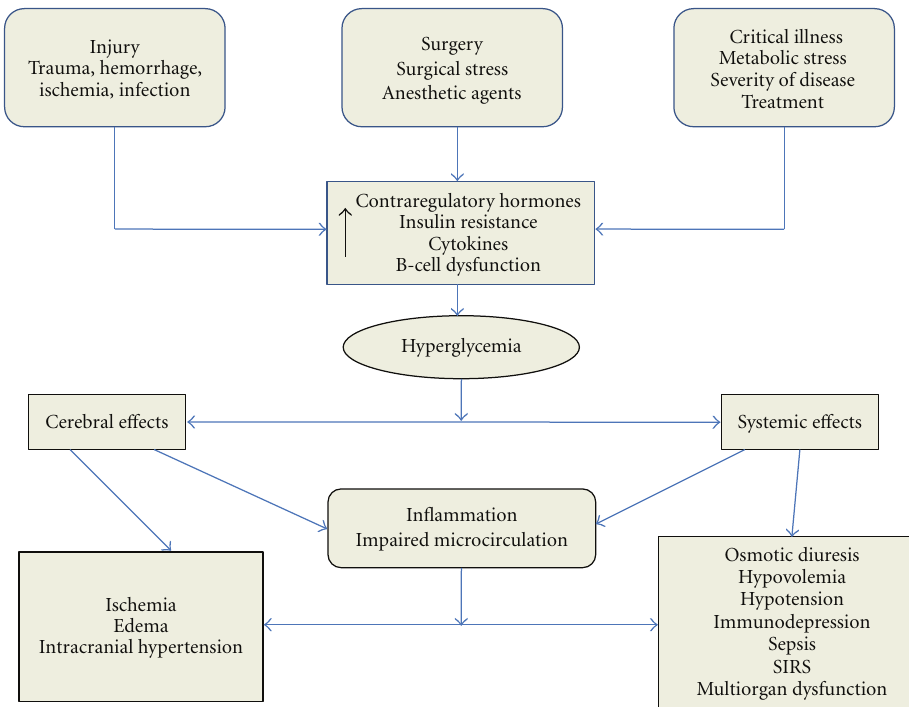
Figure 1: Causes and consequences of hyperglycemia. Where SIRS: Systemic inflammatory response syndrome.